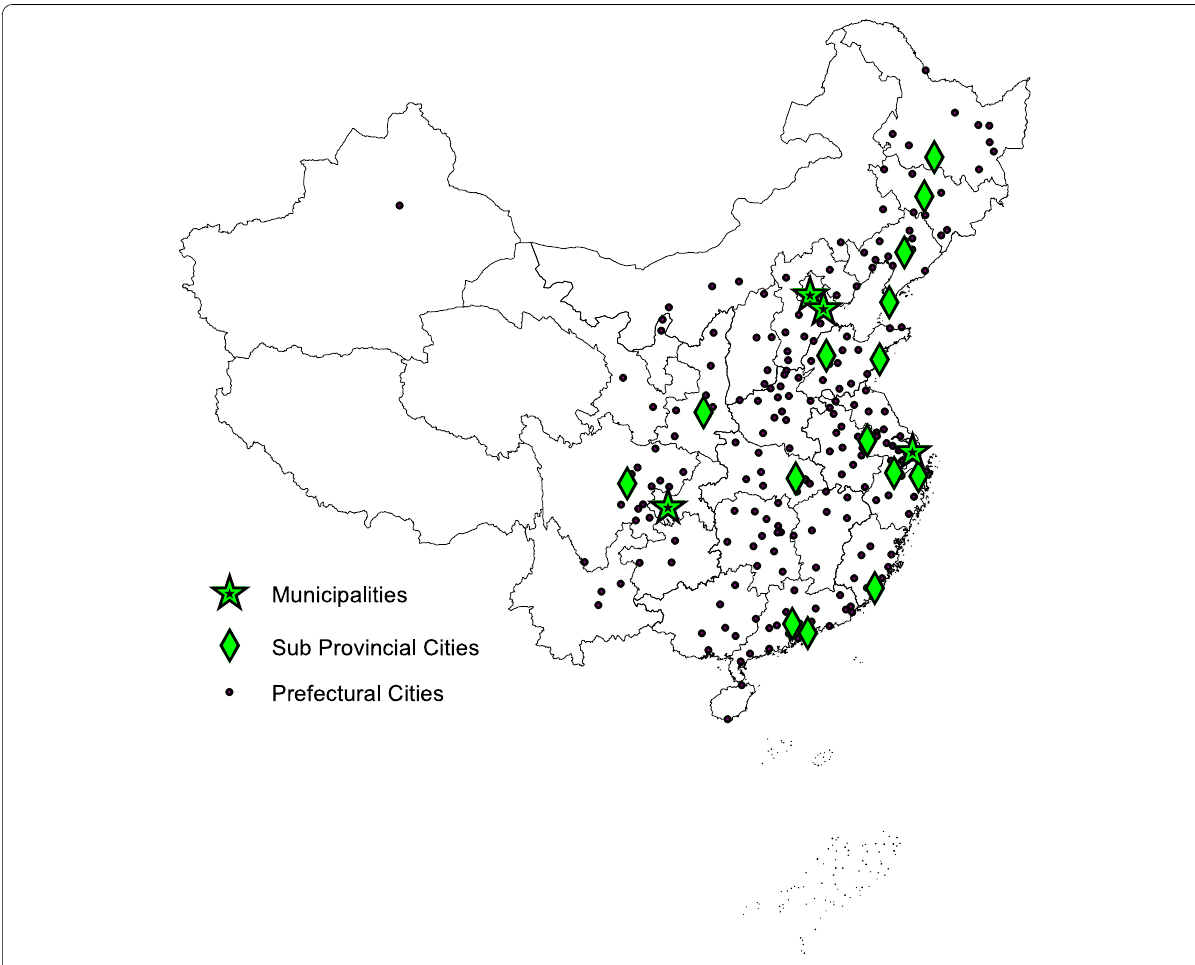
Fig. 1 The geographical distribution of cities in terms of municipalities, sub-provincial level cities, and prefectural level